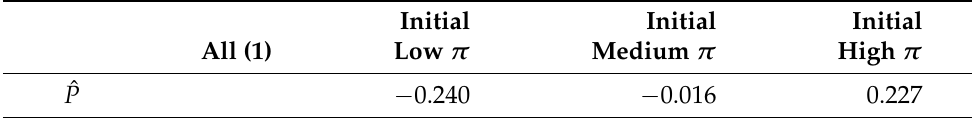
Table 3. The value of ˆ P (is calculated from the result in Table